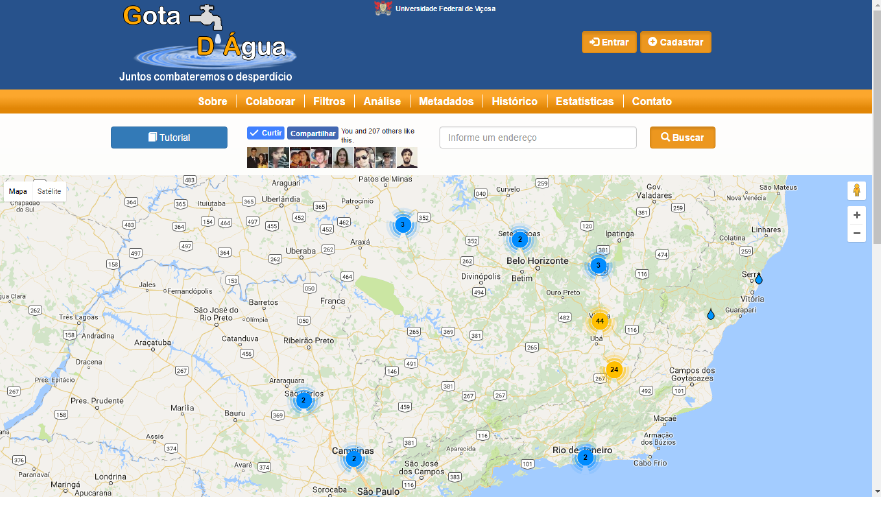
Figure 4. Home page of the Gota D’Água